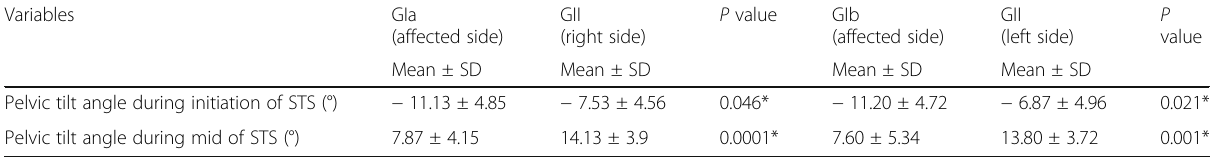
STS Sit to stand, SD Standard deviation, P probability, Significant P * < 0.05, °